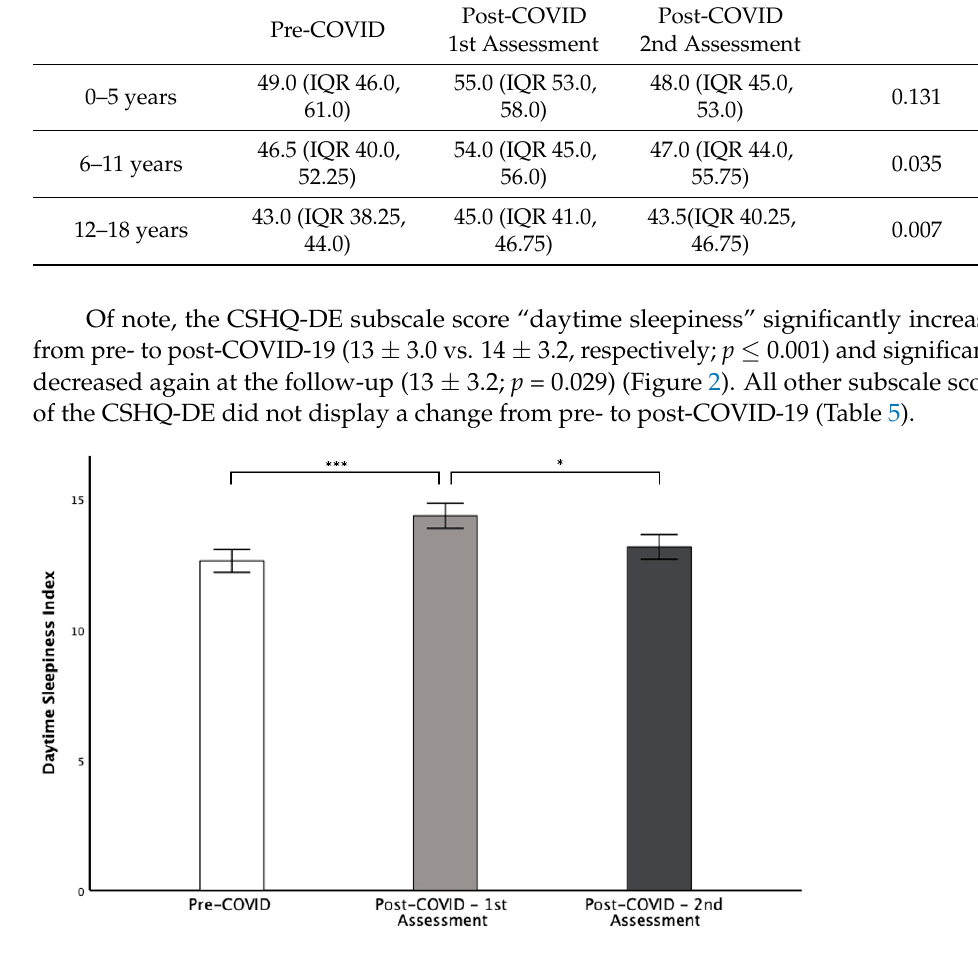
Figure 2. Subscale score “Daytime Sleepiness” pre-COVID-19 vs. post-COVID-19 initial and re-presentation: Significant increase from pre- to post-COVID-19 (13 ± 3.0 vs. 14 ± 3.2, respectively) and significant decrease at re-presentation (13 ± 3.2). Univariate ANOVA with multiple measurements and post hoc Bonferroni (*** p ≤ 0.001 and * p = 0.029, respectively). Table 5. CSHQ-DE subscales, mean (SD), ANOVA with multiple measurements and post hoc